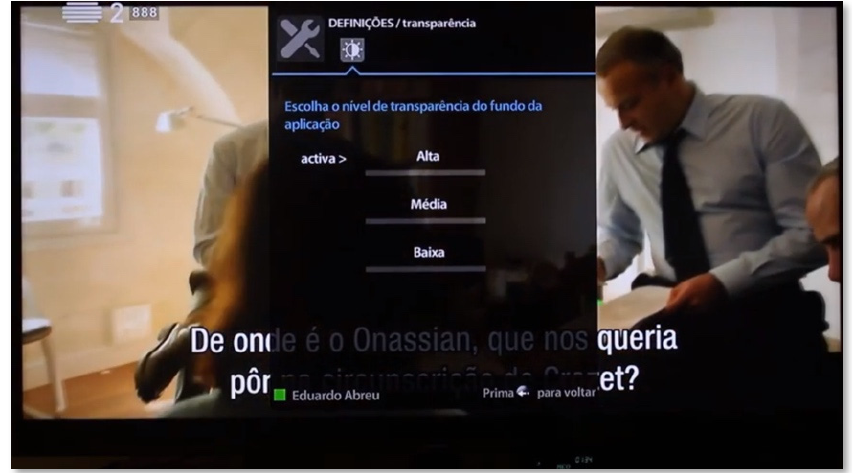
Figure 10. Settings area of the SecurHome TV application.